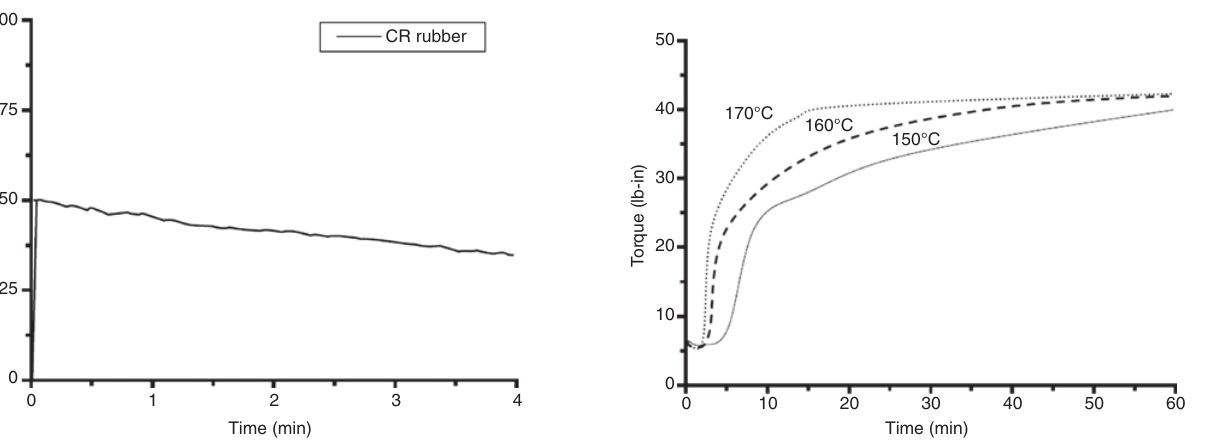
Figure 1 Mooney (M) viscosity curve of CR. Figure 2 Vulcanization curve of CR with various temperatures.